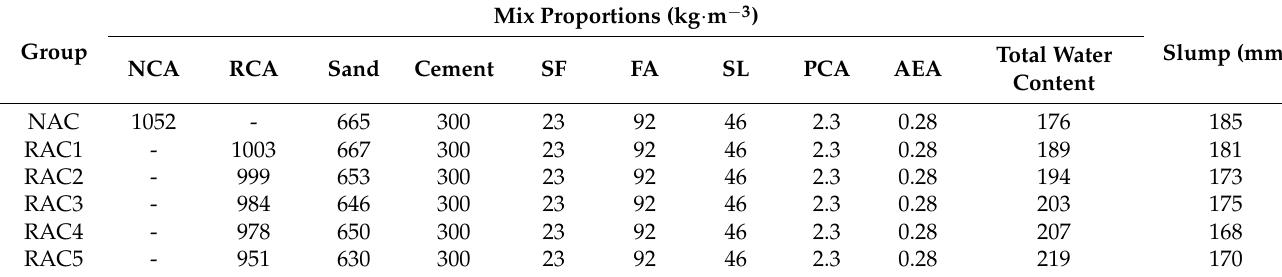
Table 2. Mix proportions and slumps.